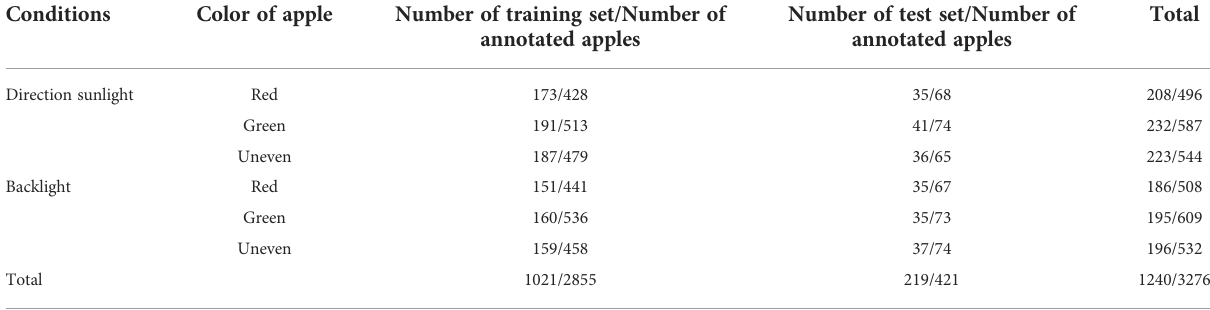
TABLE 1 Information of apple